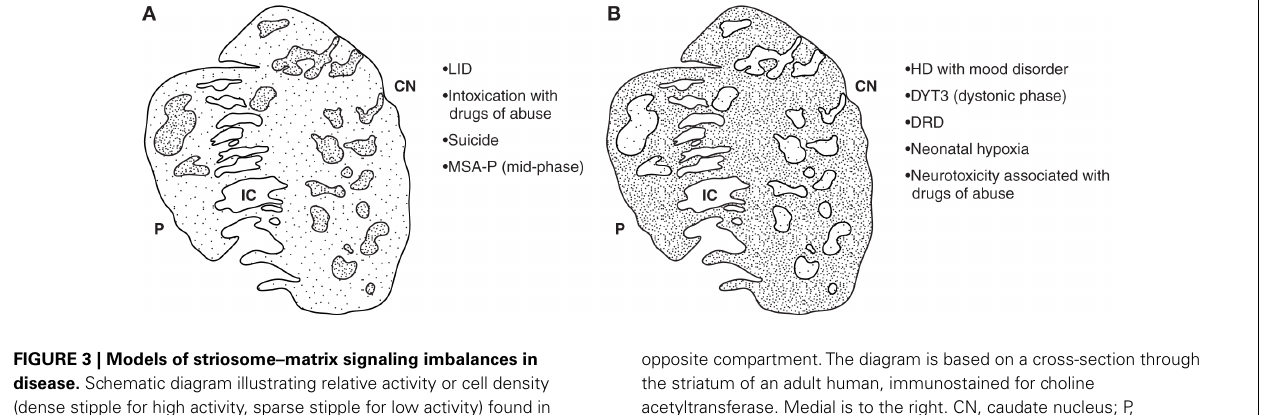
FIGURE 3 | Models of striosome–matrix signaling imbalances in disease. Schematic diagram illustrating relative activity or cell density (dense stipple for high activity, sparse stipple for low activity) found in studies of human brain and brains of animal models. For the diseases or disease models listed, observations were made of either a relative imbalance in MSN cell density, immunomarker expression or IEG induction favoring the striosomes (A) or matrix (B) , relative to the